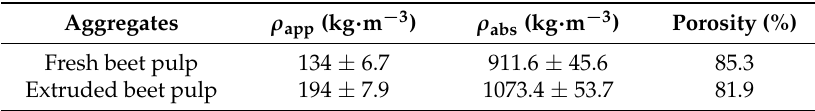
Table 1. Porosity and densities of BP.